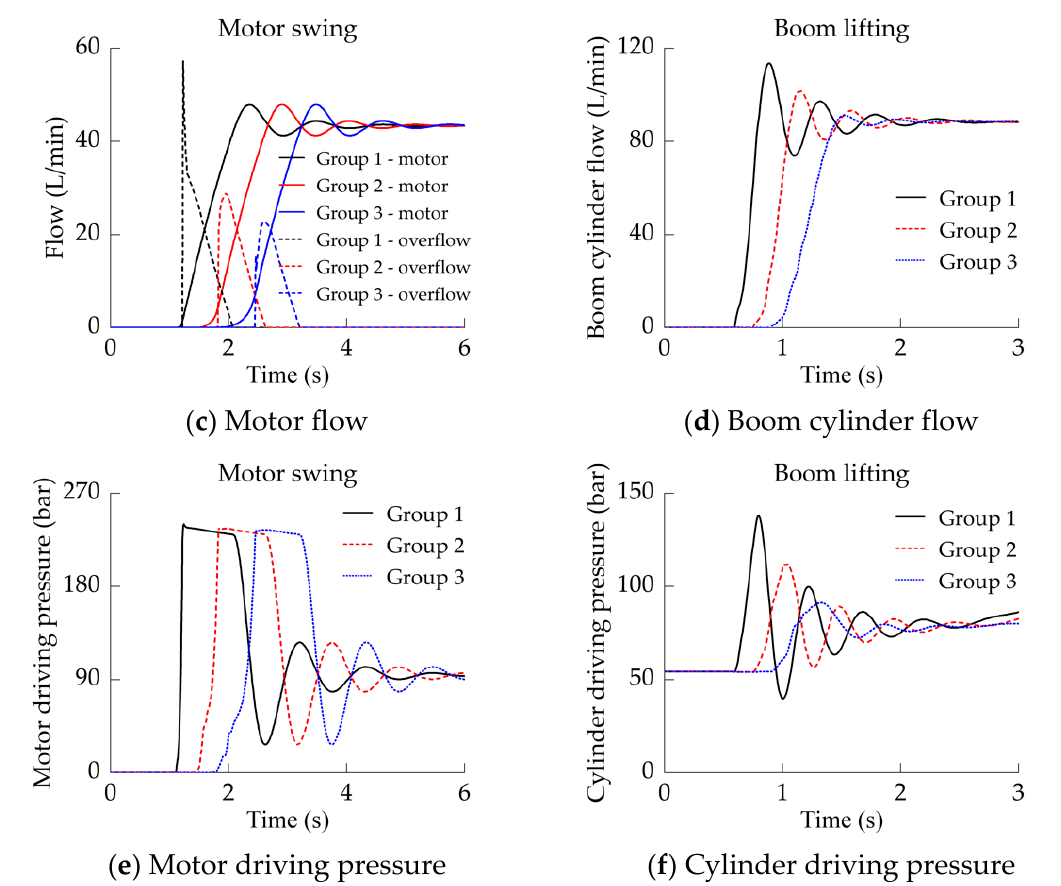
Figure 11. Ramp response characteristics of a large inertia hydraulic actuator.